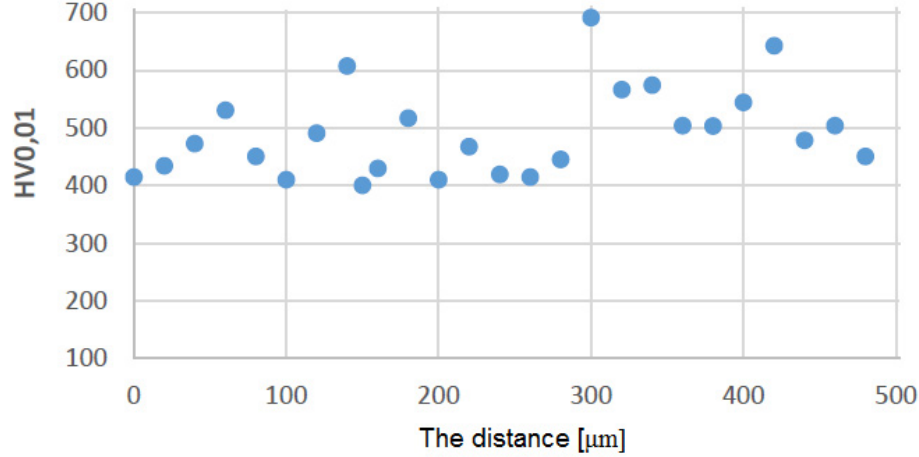
Figure 12. Distribution of microhardness on the leading edge for the protective coating made using the APS + SLURRY method.